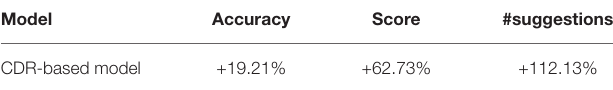
TABLE 2 | Manual annotation